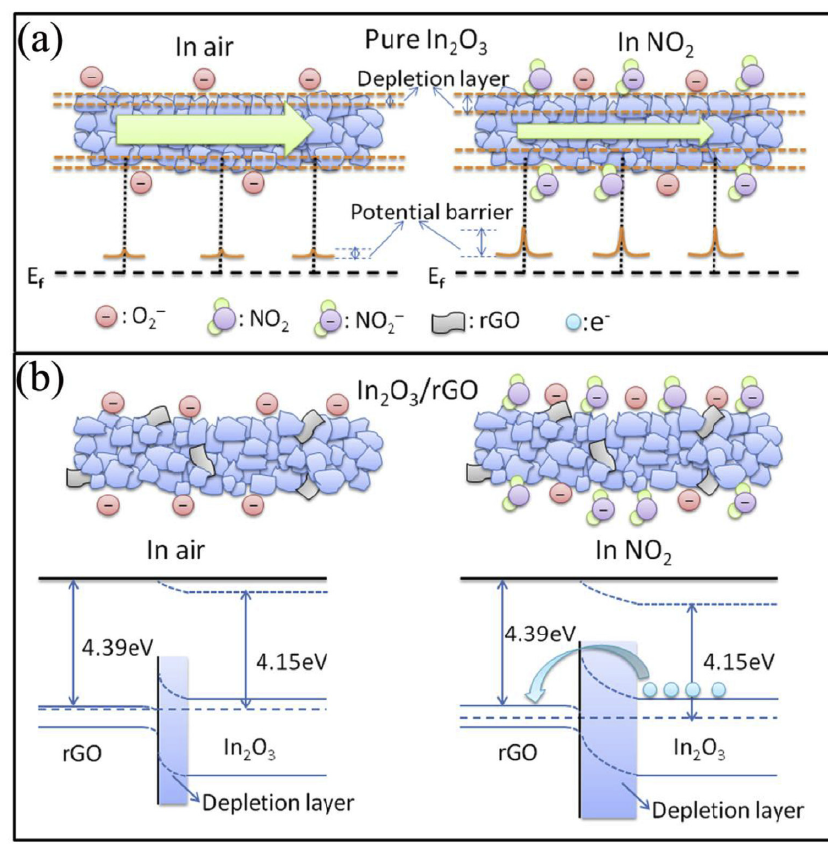
Figure 16. Gas sensing mechanism in ( a ) pristine In 2 O 3 ( b ) rGO-loaded In 2 O 3 [76].